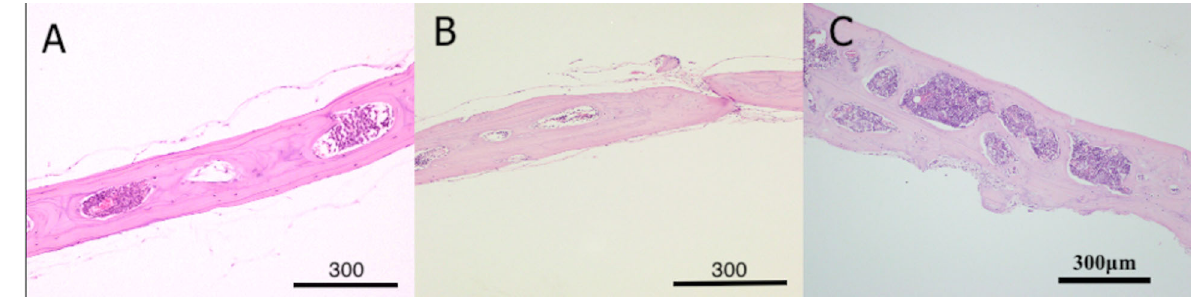
after treatment with DSM/SCPC/hBMSC onlay showing double rows of fused marrow spaces and bone thickness of 400 − 600 µm, scale bar = 300 μ